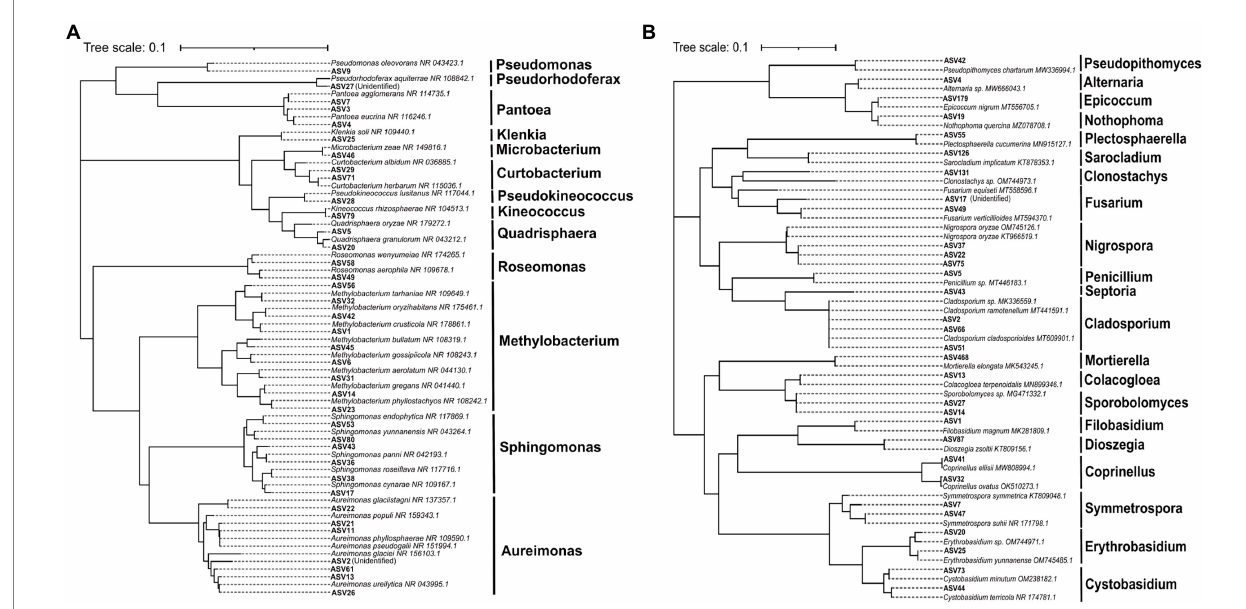
FIGURE 6 The neighbor-joining (NJ) phylogenetic tree showing the core bacterial (A) and fungal (B) ASVs of the foliar microbiome of wild